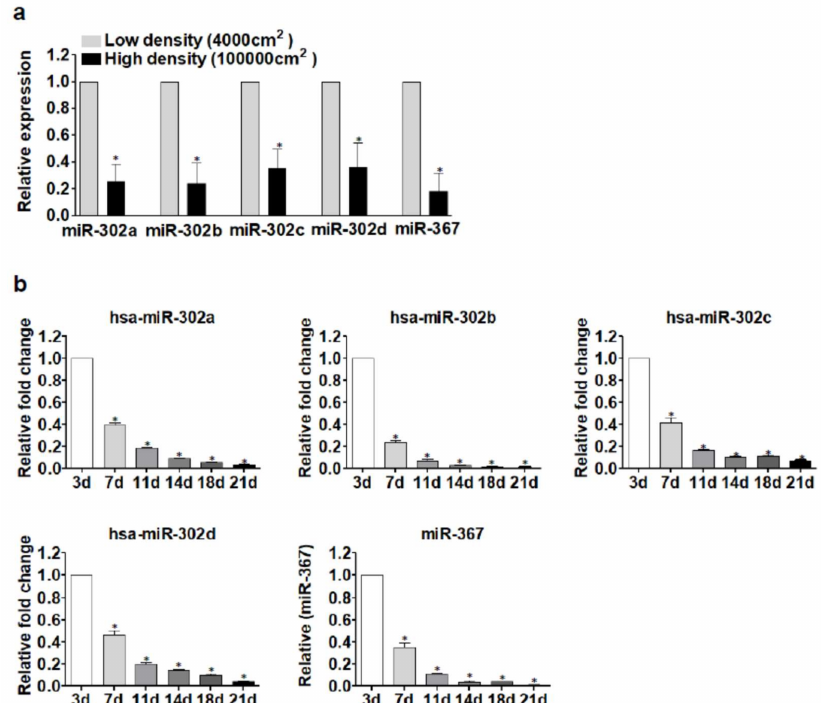
Figure 6. Cell–cell contacts contribute to the modulation of miR-302s expression. ( a ) miR-302 family members expression evaluation using stem–loop RT-Real Time PCR in dedifferentiated islet cells cultured at different density (4000 cells/cm 2 vs. 100,000 cells/cm 2 ) for 48 h. Values are reported as mean fold change ± SD vs. low density plated dedifferentiated islet cells. n = 3 independent experiments using three different human islets-derived dedifferentiated cells preparations, p -value Student’s t -test * p < 0.05. ( b ) Evaluation of miR-302s expression during re-differentiation of human islet-derived dedifferentiated cells, starting from day 3 and evaluated at day 7, 11, 14, 18, and 21. Values are reported as mean fold change ± SD vs. day 3 of re-differentiation. n = 3 independent experiments using three different human islets-derived dedifferentiated cells preparations, p -value Student’s t -test * p <